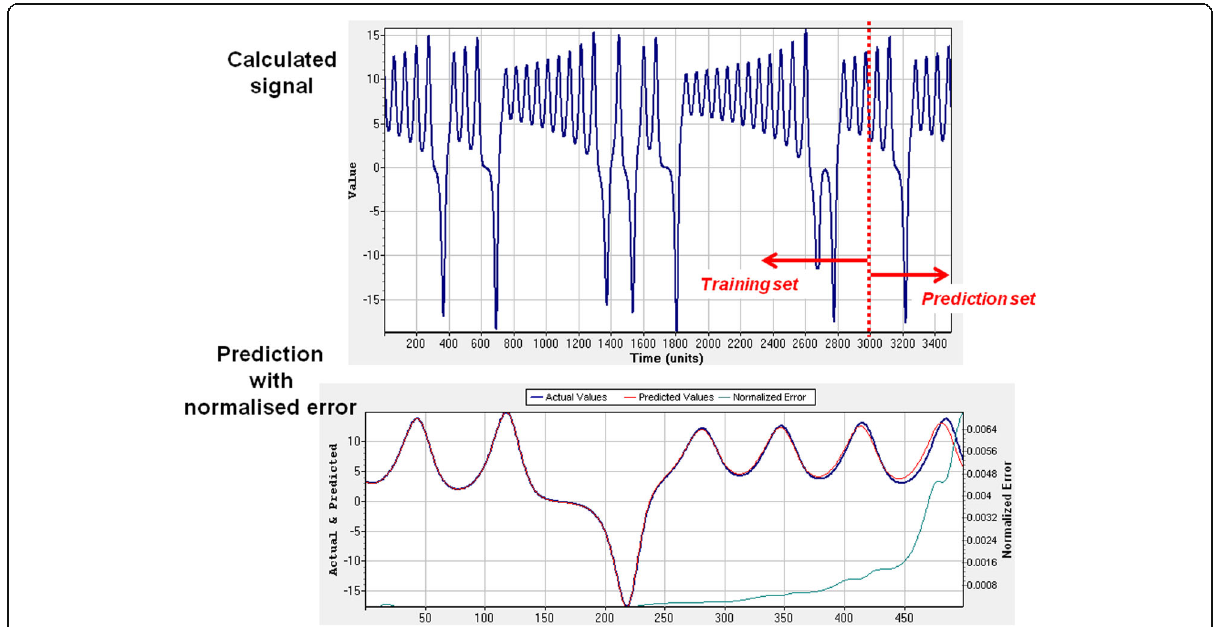
Fig. 9 Prediction in the Lorentz system. The top panel is the signal from the Lorentz system calculated from the differential equations that describe the system. We use the first 3000 steps as a training set for a nonparametric prediction over the next 500 steps in the range 3001 to 3500 steps shown in the lower panel. One can see that the prediction (in red) hugs the real signal (in black) fairly well over the first 250 steps of the prediction (normalised error <0.0008). The error is normalised relative to the prediction obtained from a linear prediction or random walk model. From then on the error begins to rise exponentially (as is to be expected from a chaotic series) and is 0.0064 (or very close to 100% of the variance in the data) at 500 steps. If one wanted to improve the accuracy of the prediction past this range then the collection of data within those last 250 steps is necessary. One sees that the predictions for this simple chaotic model are very